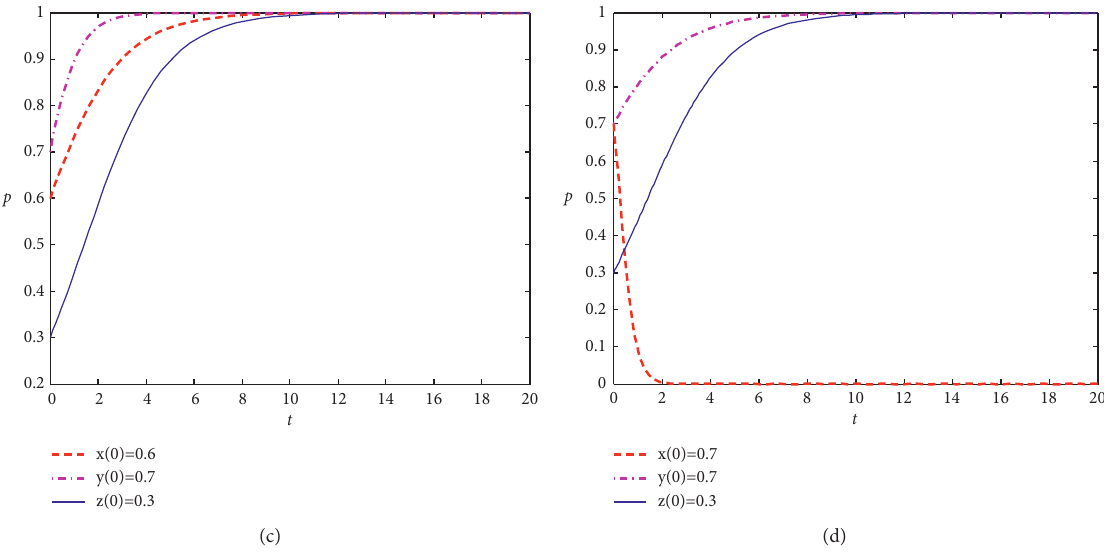
Figure 7: Strategy choices under different initial states. (a) x (0) � 0.2, y (0) � 0.7, and z (0) � 0.5. (b) x (0) � 0.1, y (0) � 0.5, and z (0) � 0.3. (c) x (0) � 0.6, y (0) � 0.7, and z (0) � 0.3. (d) x (0) � 0.7, y (0) � 0.7, and z (0) � 0.3.